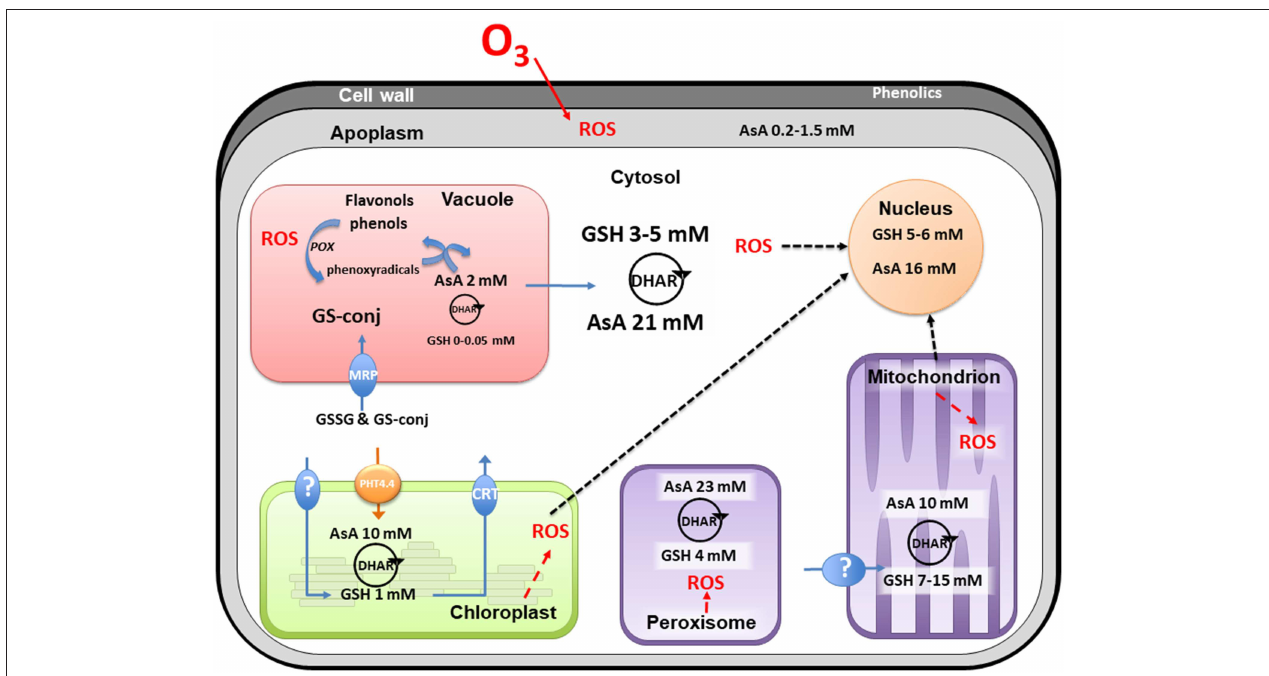
FIGURE 1 | Compartmentation of plant oxidative system. This non-exhaustive figure summarizes current knowledge from plant subcellular localization of antioxidants in non-stress conditions. In view of the multiplicity of all enzyme isoforms, the figure only mentions the presence of the HAF cycle in each compartment where the dehydroascorbate reductase (DHAR) has been characterized. AsA, total ascorbate; GSH, total glutathione; GSSG, glutathione disulphide; GS-conj, glutathione conjugates; HAF, Halliwell-Asada-Foyer; MRP, Multidrug Resistance associated Protein; CRT, Chloroquine Resistance Transporter; PHT, phosphate transporter; POX, phenol peroxidases; ROS, reactive oxygen species. See the text for